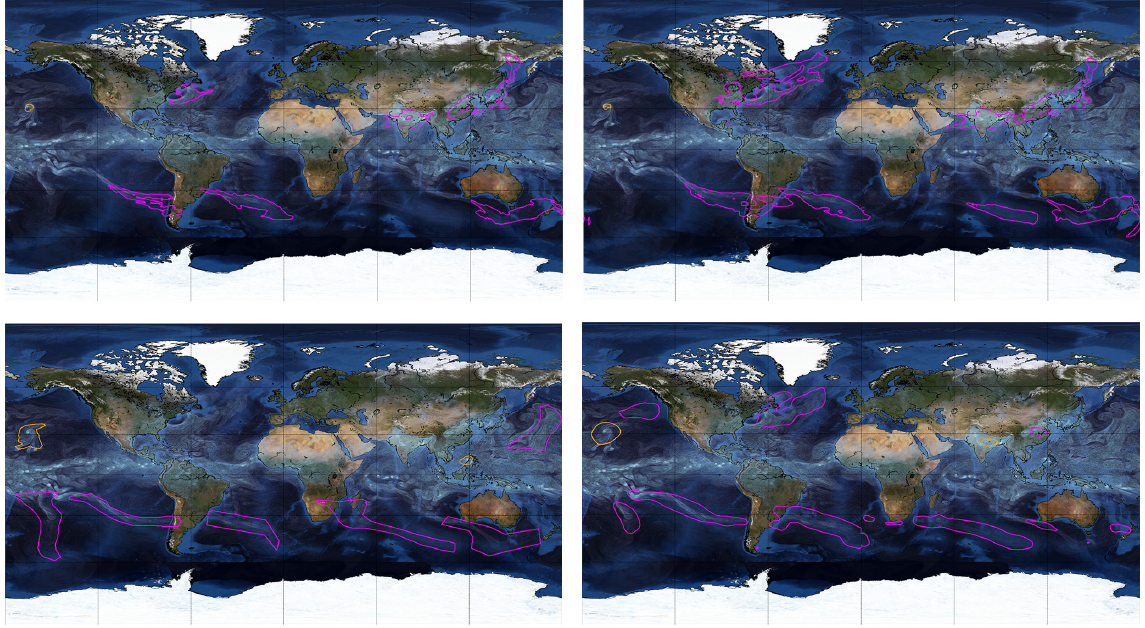
Figure 5. Comparison of labels from TECA (top left), model predictions trained on TECA (top right), the ClimateNet dataset (bottom left), and model predictions trained on ClimateNet (bottom right). The “bluemarble” map in the background included via Matplotlib’s Basemap library is ©